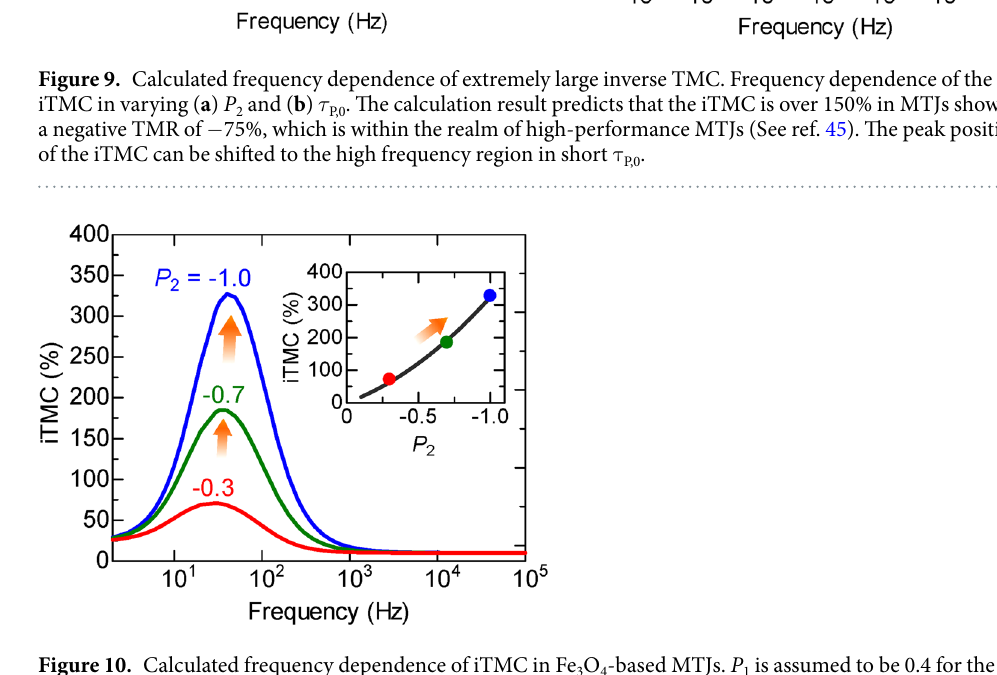
Figure 10. Calculated frequency dependence of iTMC in Fe 3 O 4 -based MTJs. P 1 is assumed to be 0.4 for the spin polarization of Fe (See ref. 46). The iTMC of over 300% is predicted in MTJs using Fe 3 O 4 , which could be a half metal with a P 2 of − 100% (blue line and